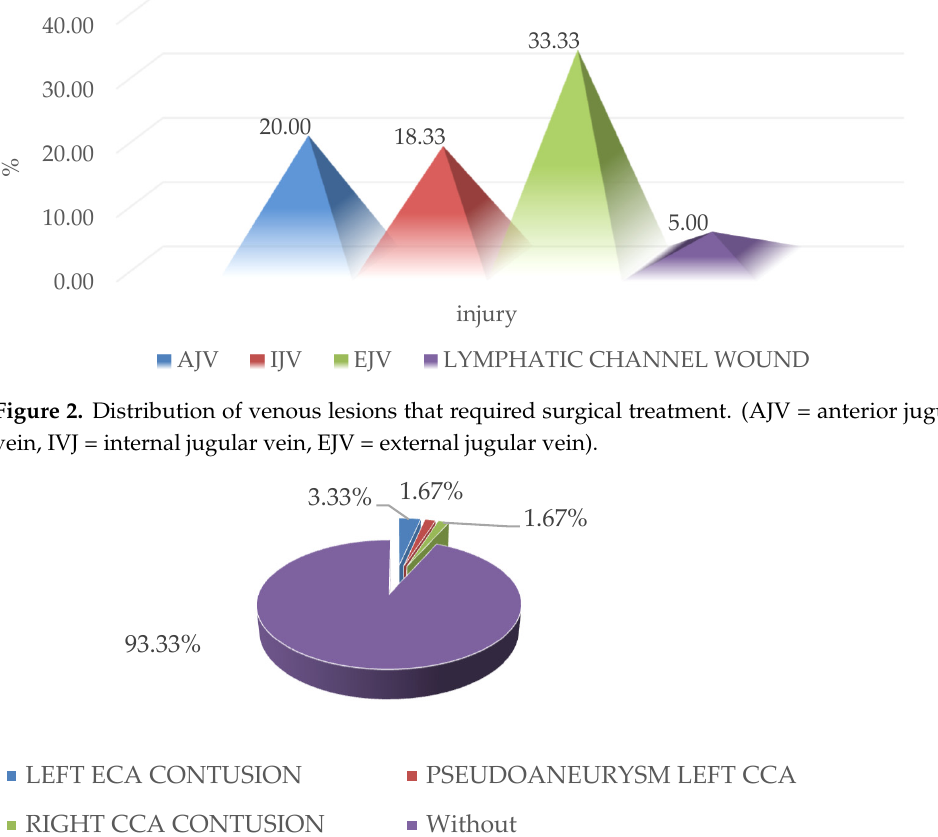
Figure 3. Distribution and characteristics of carotid lesions that required specific surgical treatment. (ECA = external carotid artery, CCA = common carotid artery)